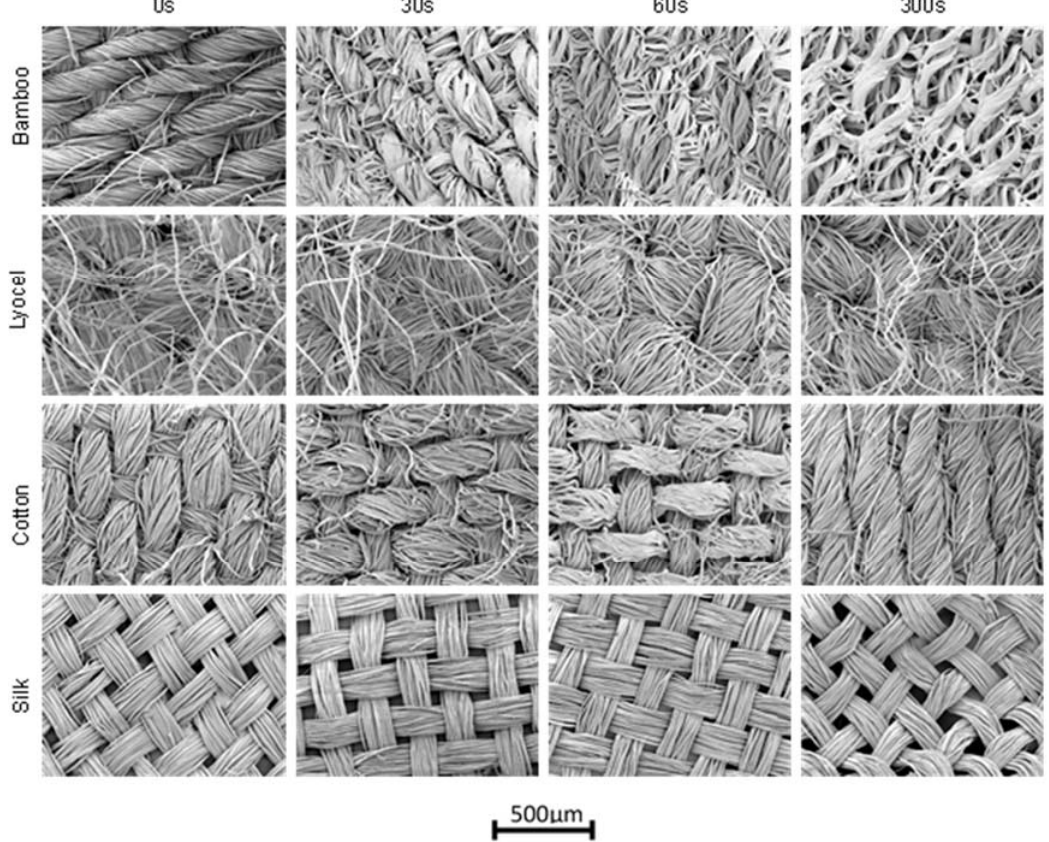
Figure 1. Time course of the effect of sodium hydroxide on natural fibres. Labels on the left refer to all images in that row. The time in seconds of exposure detailed across the top of the figure refer to all images in that column. The red scale bar in the bottom right represents a length of 500 µ m on the images, all of which have the same scale.